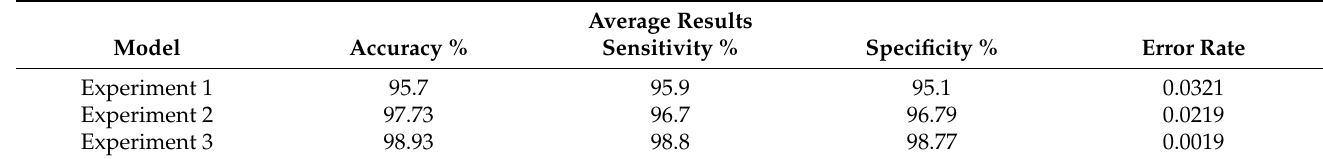
Table 13. Experimental results for the three experiments with transfer